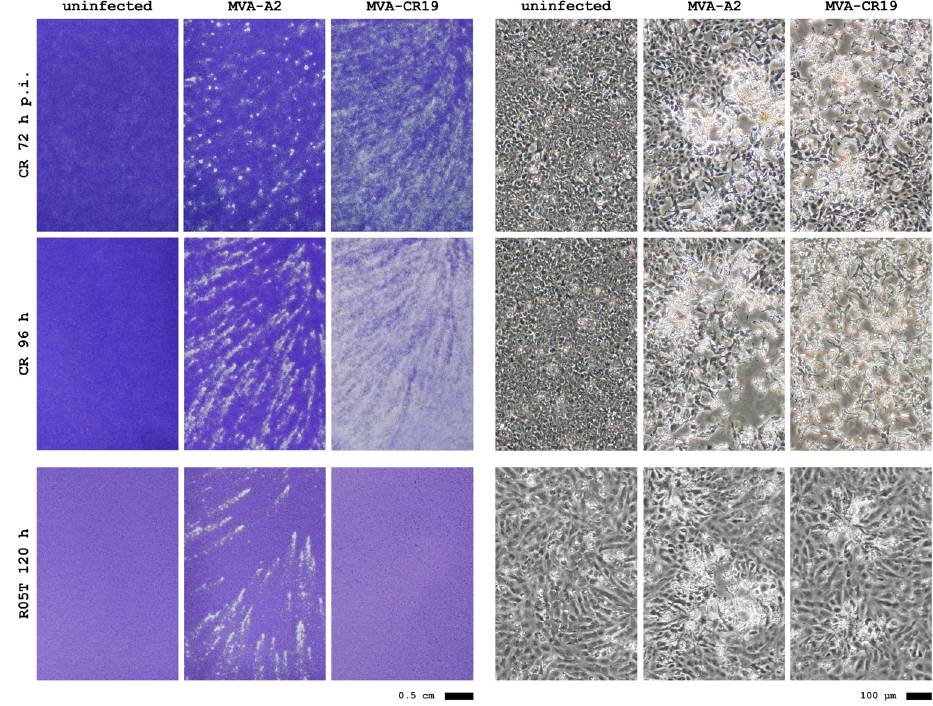
Figure 3. Plaque phenotypes of MVA-A2 and MVA-CR19 in CR and R05T cell monolayers stained with crystal violet (left panel) and at 40 × initial magnification of live cells (right panel). Note that MVA-CR19 causes plaques in R05T (see microscope image) but that these are too small to be visible to the unaided eye in the crystal violet-stained